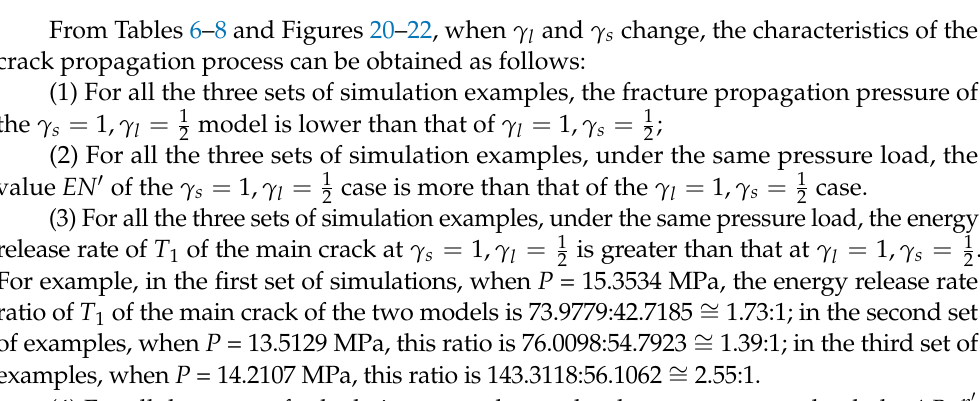
Figure 22. Variations of 𝛾 (cid:3039) and 𝛾 (cid:3046) in the third set of the example. ( a ) 𝐺 (cid:3010)(cid:3021)(cid:2869) − 𝛾 (cid:3039) , 𝐺 (cid:3010)(cid:3021)(cid:2869) − 𝛾 (cid:3046) , ( b ) ∆𝐵𝑥 (cid:3043)’ − 𝛾 (cid:3039) , ∆𝐵𝑥 (cid:3043)’ − 𝛾 (cid:3046) .